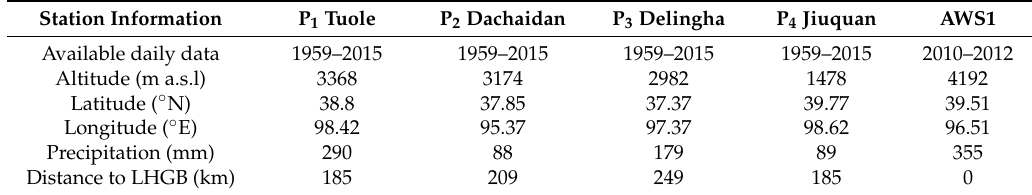
Table 1. Description of the AWS1 and four NAWS around the LHGB.